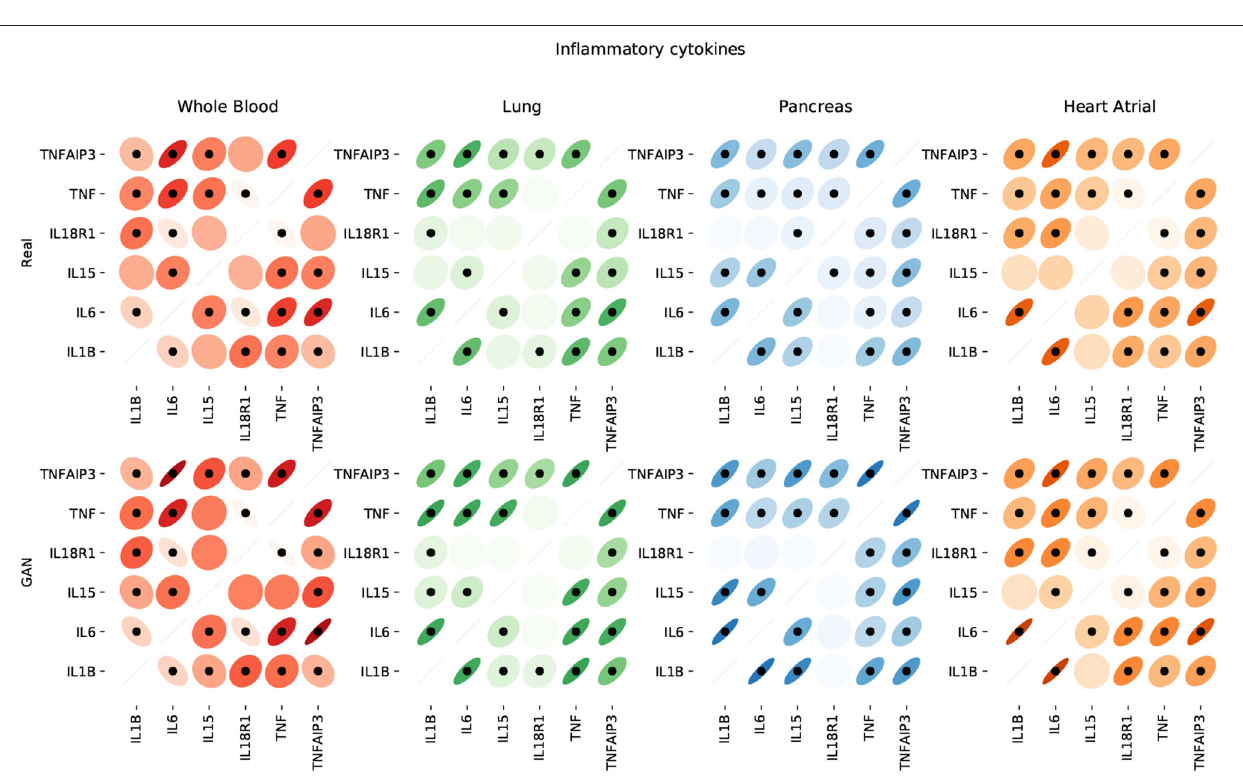
known to have effects on blood pressure (Groth et al.,